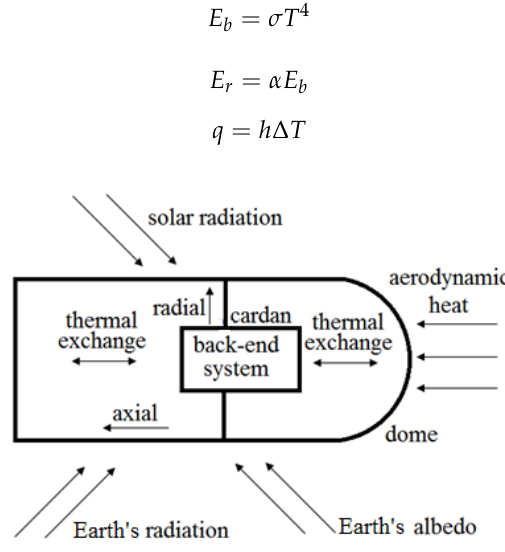
Figure A1. The thermal environment for an airborne optical system.